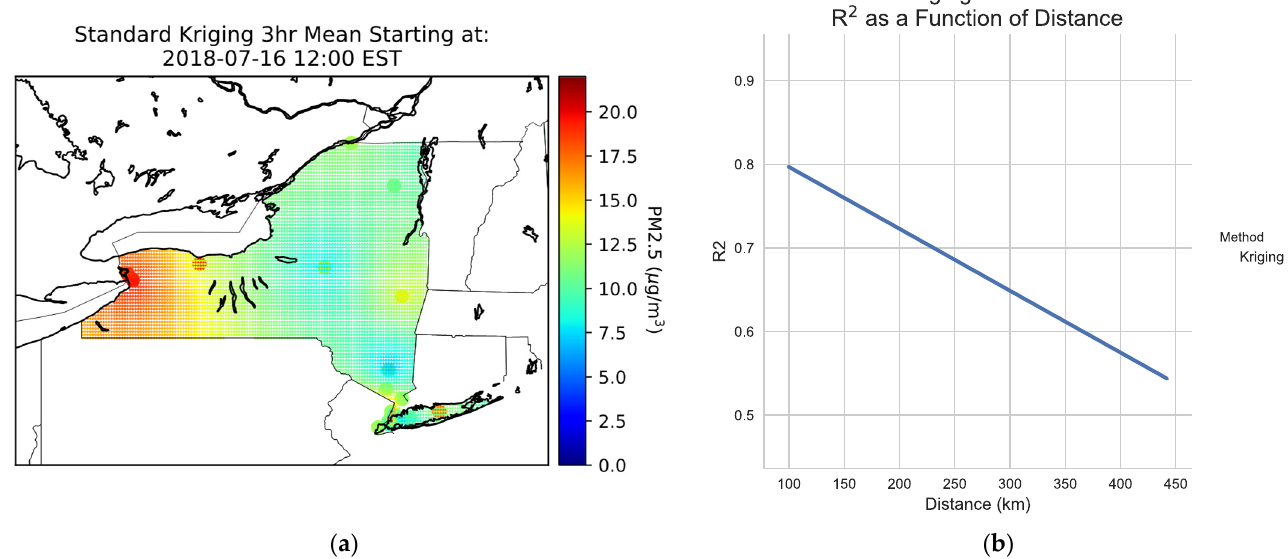
Figure 3. Simple Kriging: ( a ) Spatial interpolation over New York State (NYS) using simple Kriging, ( b ) regression score as a function of mean distance from the target location to all other locations. Regression was calculated from the hourly kriging results for all stations for 2016.